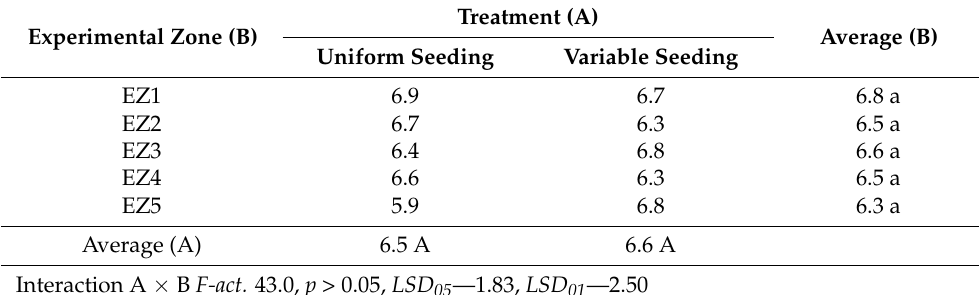
Table 7. Air-dried biomass of winter wheat seedlings in different zones and seeding treatments of the experiment ( · 10 − 2